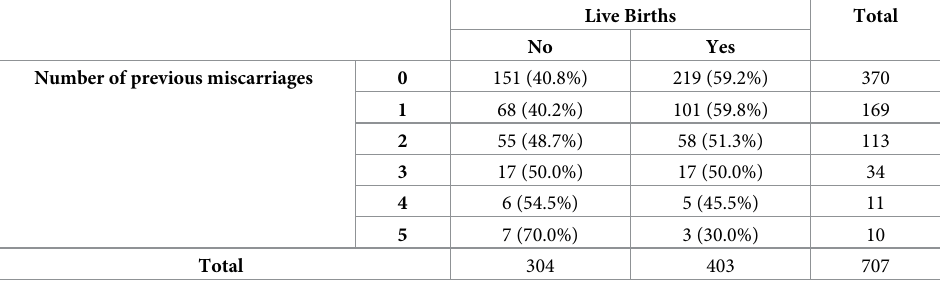
Table 5. Number of miscarriages and live